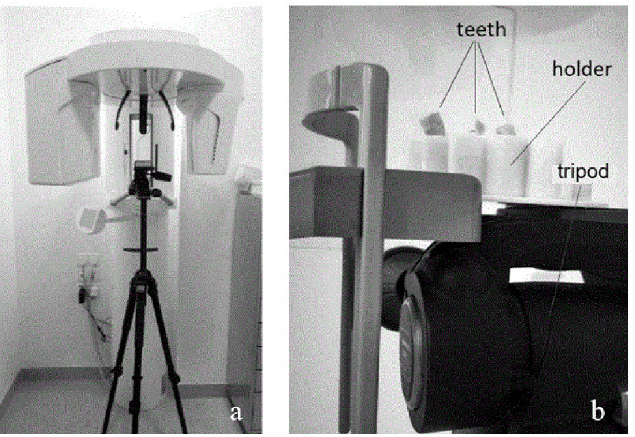
Fig 2. Experimental setup to create CBCT images. (a) Overview image of the CBCT device (Orthophos XG 3D, Dentsply Sirona; York, PA, USA) and tripod. (b) Detailed image of the tripod with plastic holder and teeth.